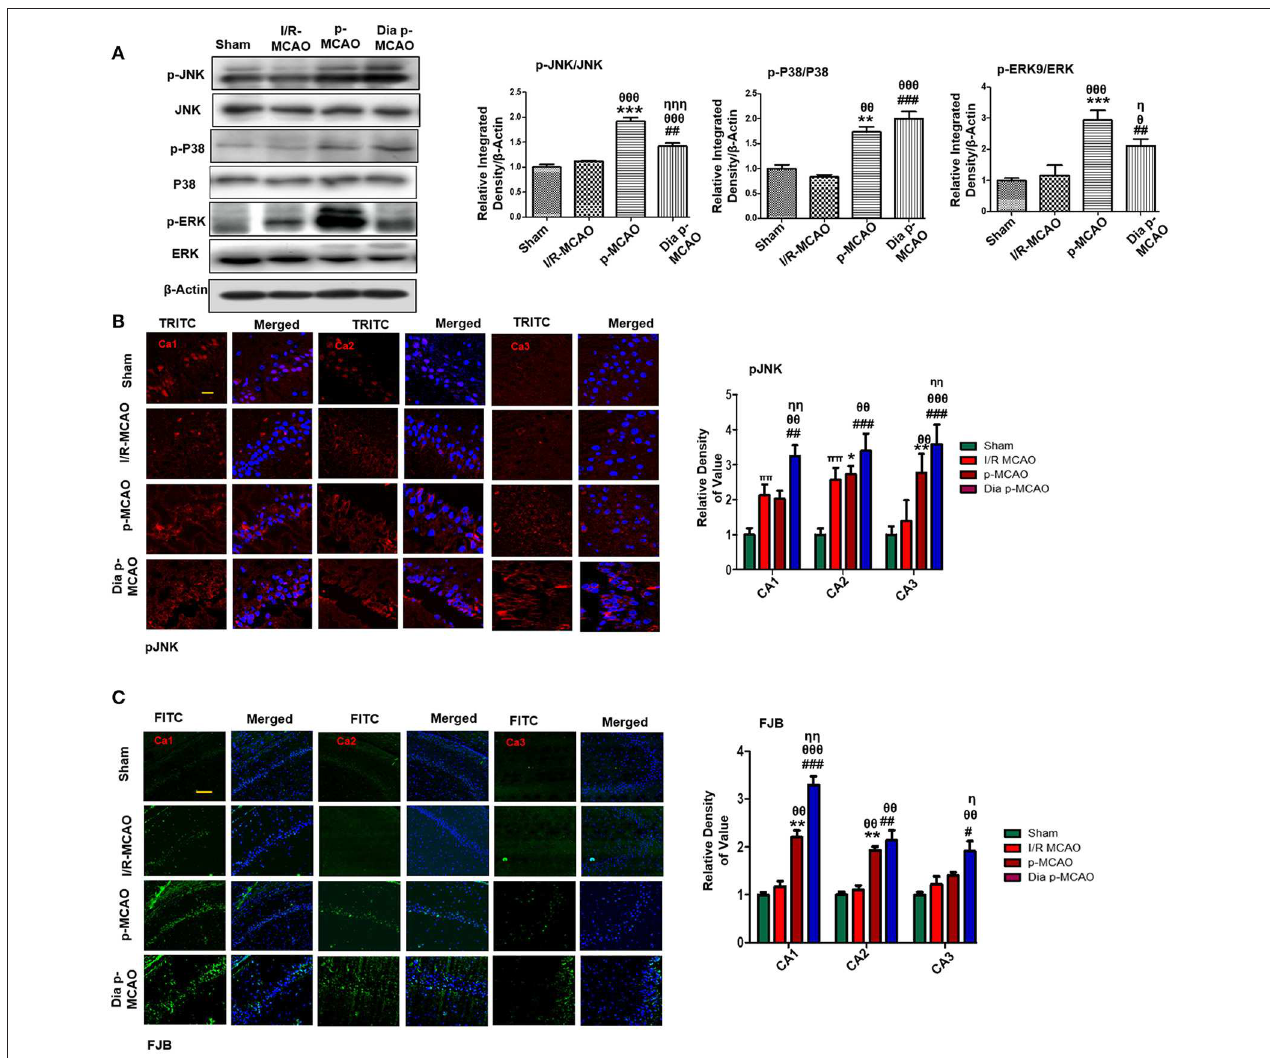
FIGURE 3 | Ischemia induced cell stress and death related signaling changes (A) Representative Western blots of p-JNK, JNK, p-P38, P38, p-ERK, ERK. Densitometric analysis was expressed in relative to β -Actin ( n = 5/group). (B) Representative images of p-JNK immunoreactivity in CA1, CA2, and CA3 regions of hippocampus in I/R, p-MCAO and Dia p-MCAO group ( n = 5/group). scale bar = 100 µ m. (C) Representative images of FJB histochemistry showing apoptotic cells; scale bar = 30 µ m. Significant neuronal apoptosis in CA1, CA2 and CA3 region of hippocampus was observed in p-MCAO and Dia p-MCAO group ( n = 5/group). θ p < 0.05 relative to I/R MCAO, η p < 0.05 between p-MCAO and Dia p-MCAO. * p < 0.05, # p < 0.05, and π p < 0.05 relative to sham group. *** p < 0.001, ** p < 0.01, ### p < 0.001, and ## p < 0.01. θθ shows significant difference of p-MCAO and Dia p-MCAO to I/R, and its value is p < 0.01, θθθ shows significant difference of p-MCAO and Dia p-MCAO to I/R, and its value is p < 0.001, ηη shows significant difference between p-MCAO and Dia p-MCAO, and its value is p < 0.01, ηηη shows significant difference between p-MCAO and Dia p-MCAO, and its value is p <